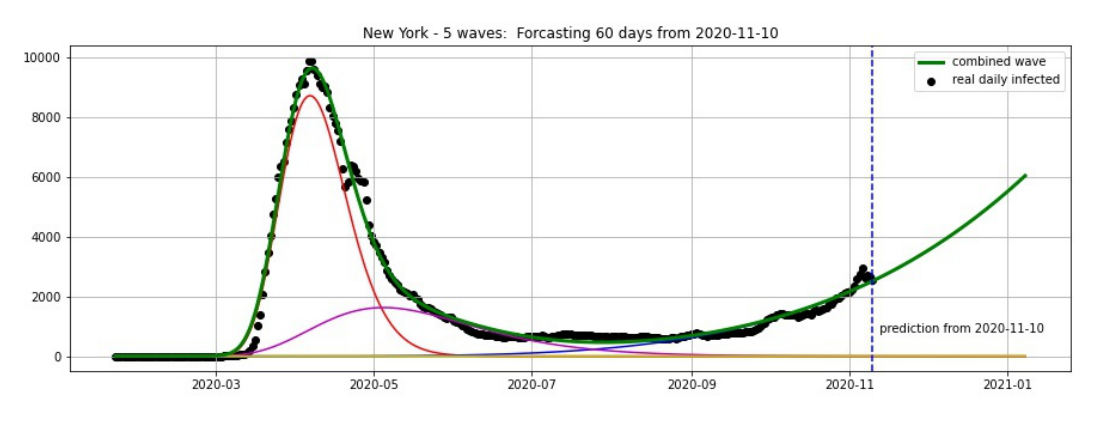
Figure 18. Florida: fitting and forecasting from 10 November 2020. The green curve is the combination of other curves which are EF wavelets.